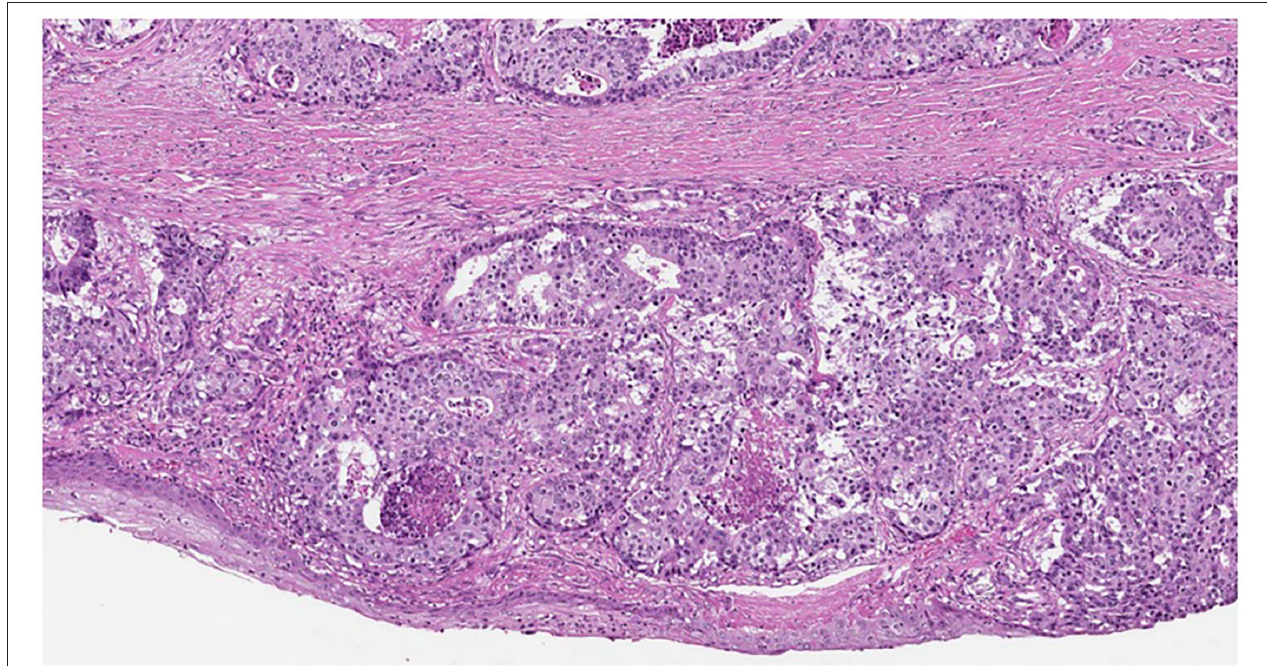
FIGURE 3 | Tumor structures near the urethra (HE, original magnification × 100).